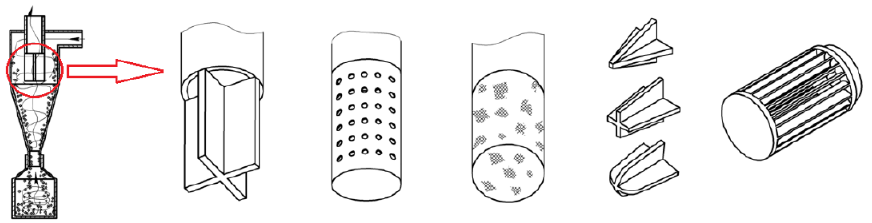
Figure 16. Devices proposed by LG Electronics to reduce pressure loss in cyclones. Figure made by author based on data from paper [83].